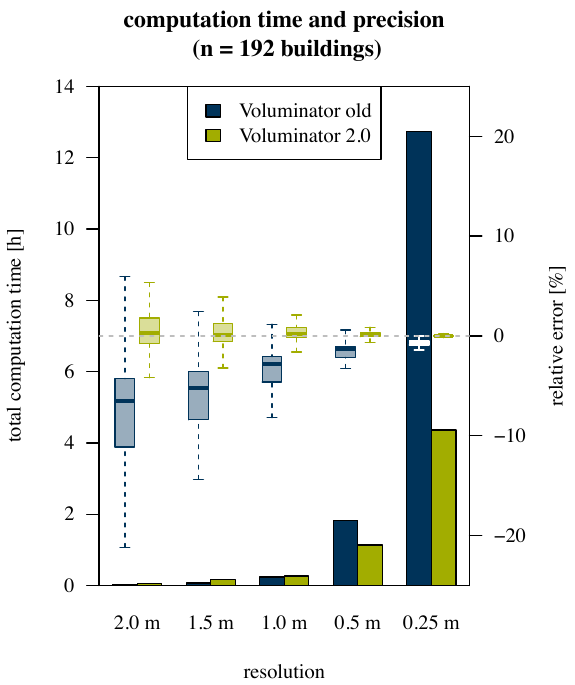
Figure 11: Accuracy (boxplot referring to the right y-axis) and total computation time (barplot referring to the left y-axis) for the original (blue) and the recursive (green) approach of approximat- ing the building volume for defective solid boundaries ( > 5% of the solid boundary surface is missing).